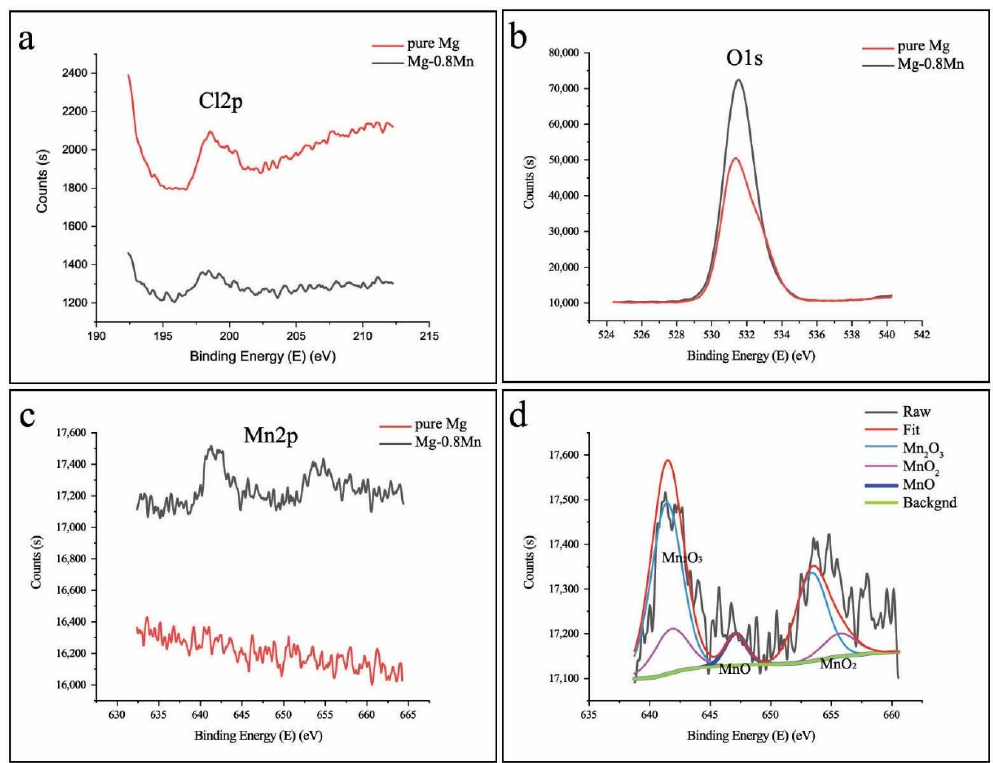
Figure 5. XPS spectra of the corrosion surface of the SLMed Mg and SLMed Mg-0.8Mn: ( a ) Cl2p; ( b ) O1s; ( c ) Mn2p; ( d ) curve fitting of Mn2p for the SLMed Mg-0.8Mn.